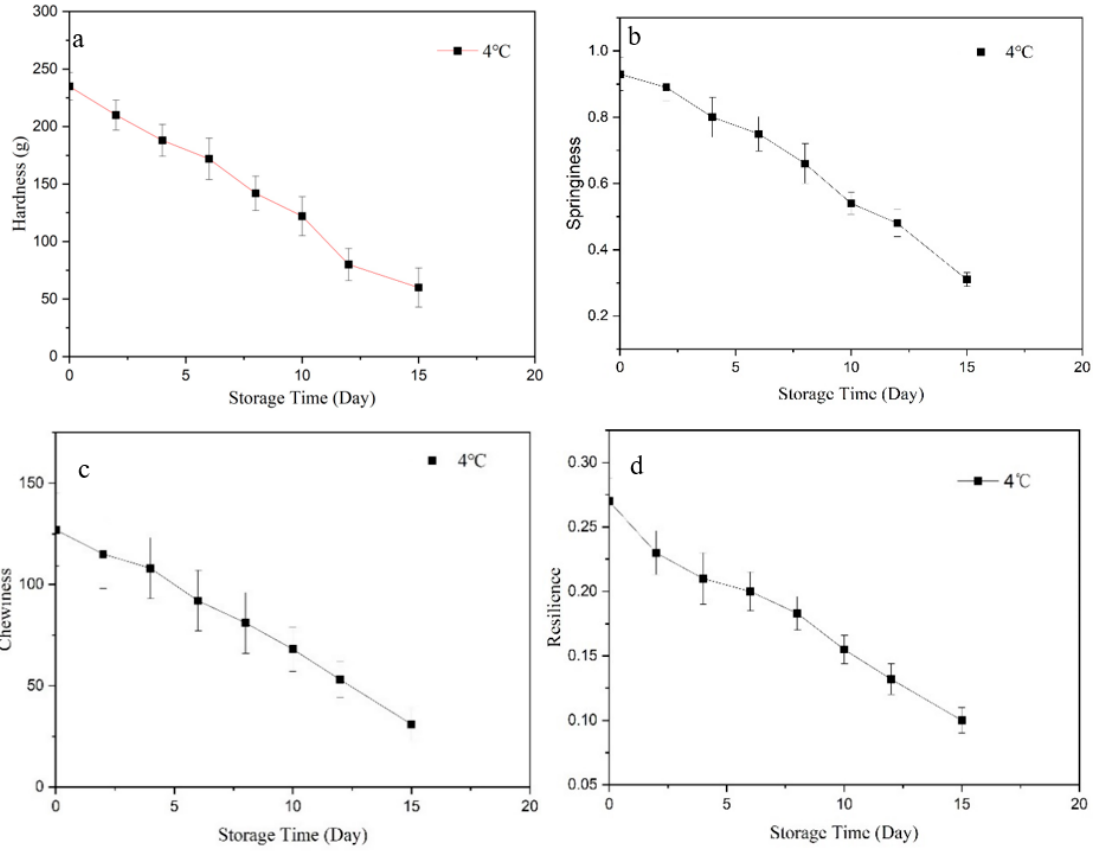
Figure 2. The texture of crawfish at 4 °C in vacuum packaging. (( a ): hardness; ( b ): springiness; ( c ): chewiness; ( d ): resilience).